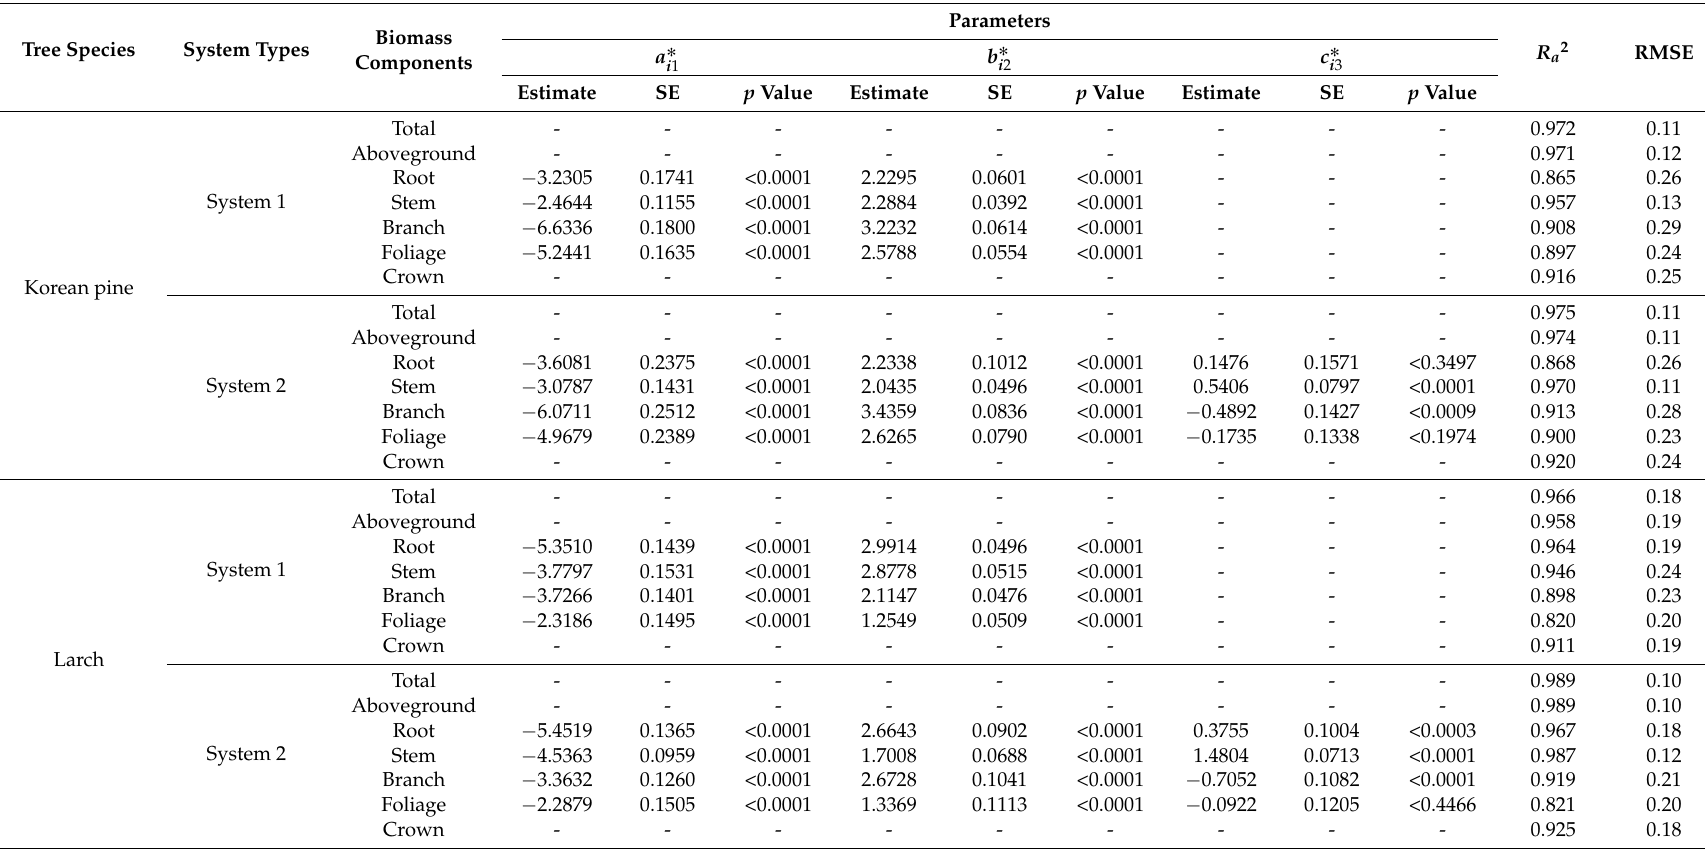
Table 4. Model coefficient estimates and goodness-of-fit statistics of log-transformed biomass equations with three constraints, using the SUR estimation method.